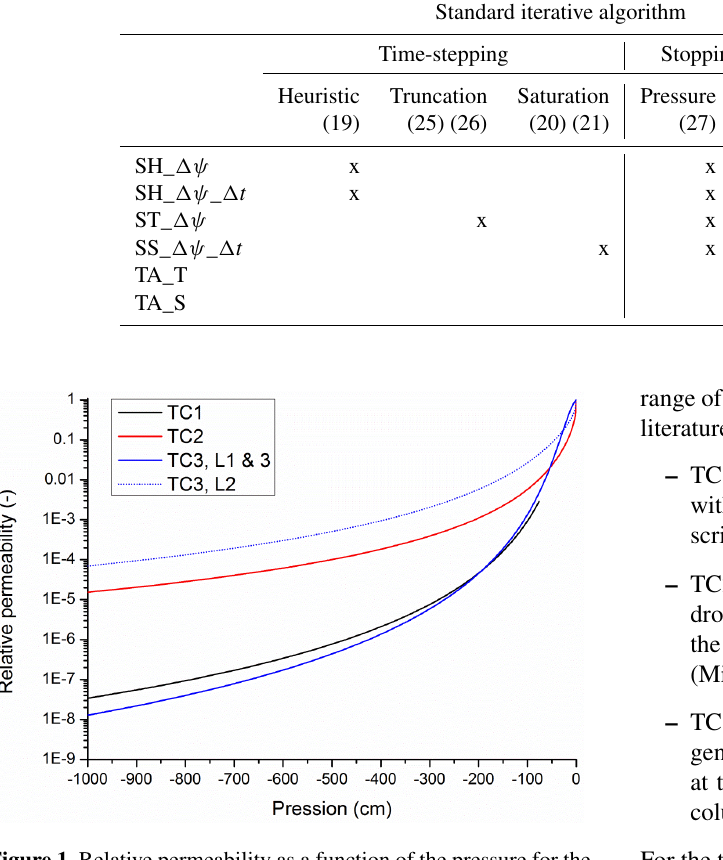
Figure 1. Relative permeability as a function of the pressure for the three test cases (L1, L2 and L3 are the three layers for test case